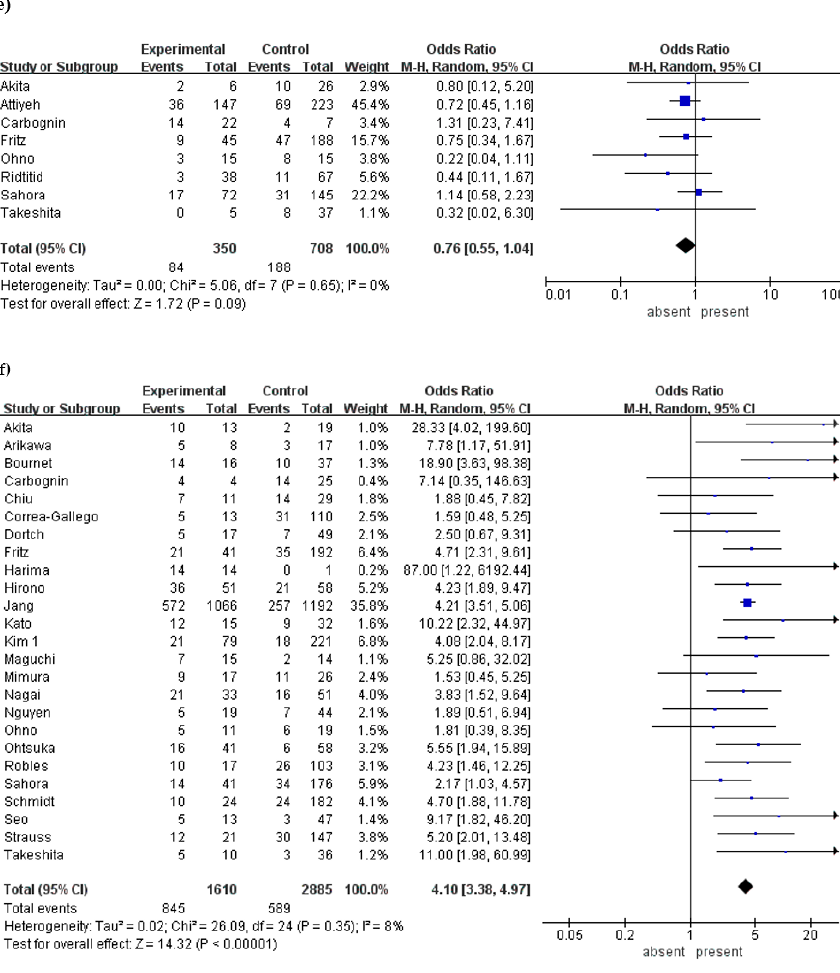
Figure 2. Forest plot showing the incidence of malignancy in BD-IPMN stratified by symptoms, characteristics of the cyst, and presence of mural nodule. ( a ) symptom. ( b ) cyst size. ( c ) cyst wall thickening. ( d ) multilocular cyst. ( e ) multiple cyst. and ( f ) mural nodule.